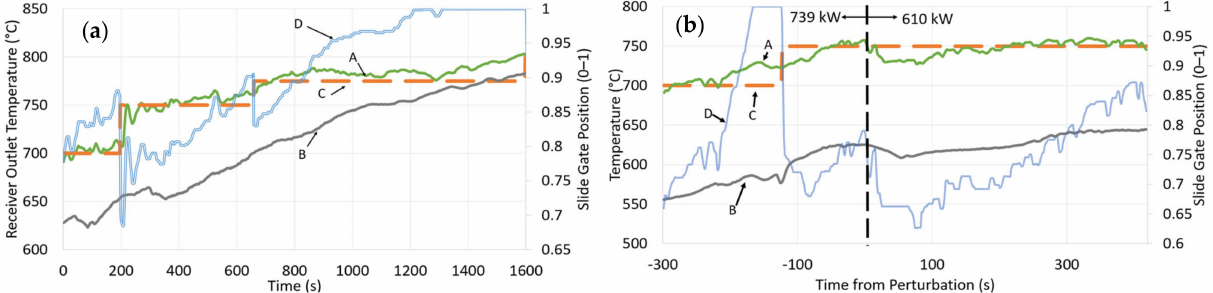
Figure 9. Long-term receiver operation ( a ) and in response to a flux perturbation ( b ); receiver outlet temperature A, receiver inlet temperature B, and receiver outlet temperature setpoint C and slide gate position D